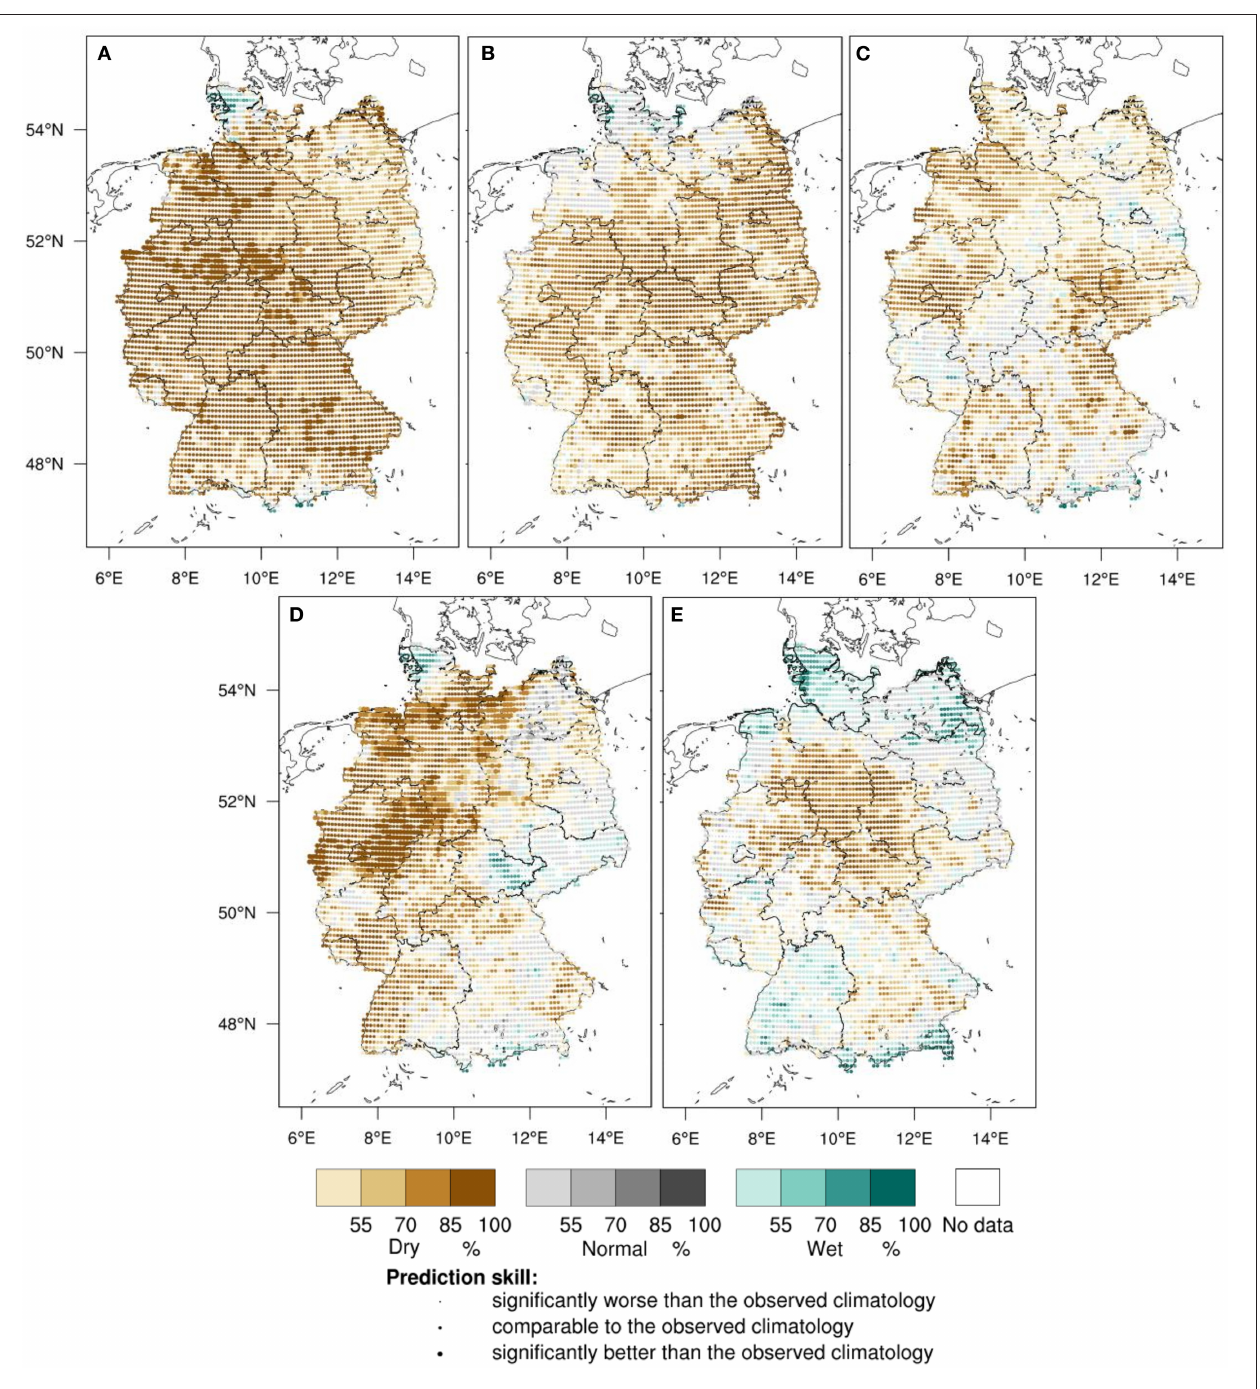
FIGURE 7 | Decadal probabilistic prediction for 3-year SPI of January–December (A) , February–April (B) , May–July (C) , August–October (D) and November–January means (E) for forecast years 1–3: The color represents the most probable category (dry/normal/wet) in comparison to the climate characteristics for 1981–2010. The brightness describes the predicted probability of occurrence of this category. The size of the dots shows the RPSS prediction skill in the evaluation period 1962–2020 (cf., Figure 5